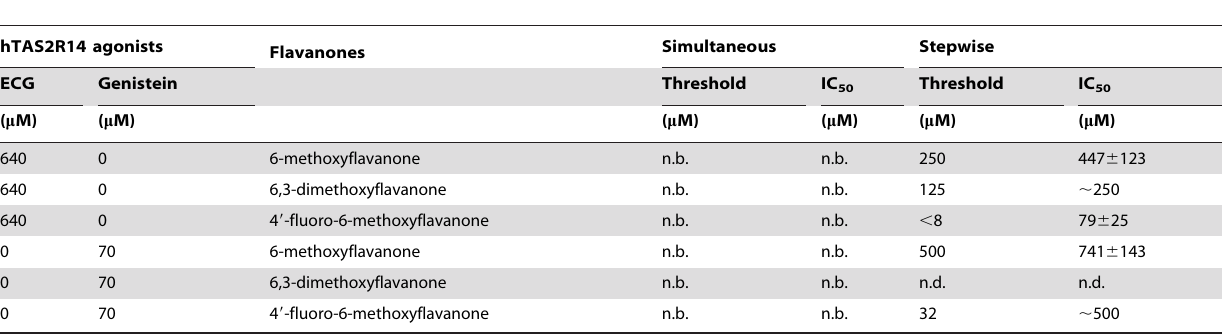
Table 3. Thresholds and IC 50 values of 6-methoxyflavanones for inhibition of hTAS2R14 responses towards 640 m M ECG and 70 m M genistein.